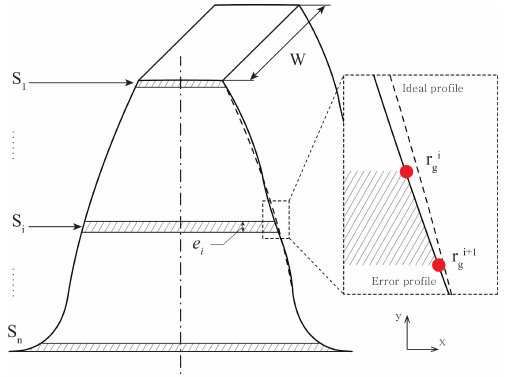
Figure 8. Nonuniform cantilever beam gear model with